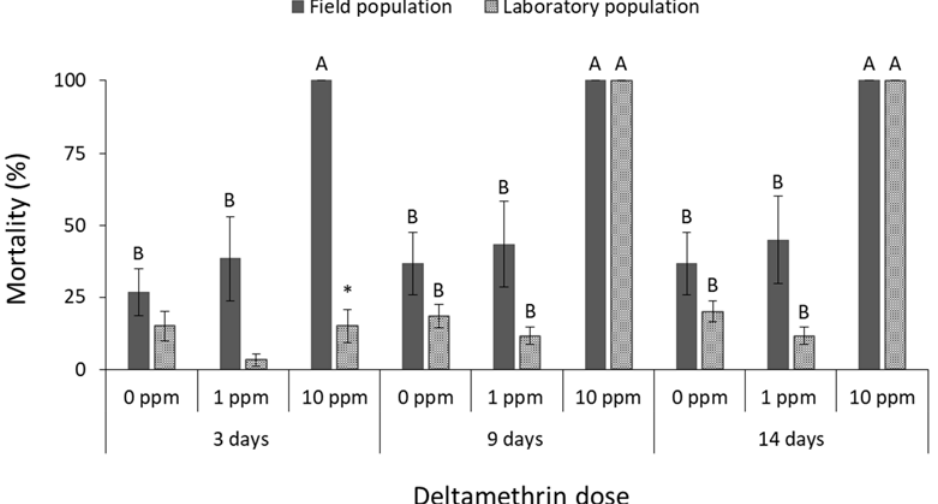
Figure 4. Mean (% ± SE) adult mortality of field and laboratory populations of S. zeamais after 3, 9 and 14 days of exposure to different concentrations of deltamethrin (within each exposure interval and population, means followed by the same letter are not significantly different; where no letters are present, no significant differences were noted; HSD test a 0.05; within each exposure interval and dose, means with asterisk (*) indicate significant differences between the populations, according to Students’ t –test at p < 0.05).